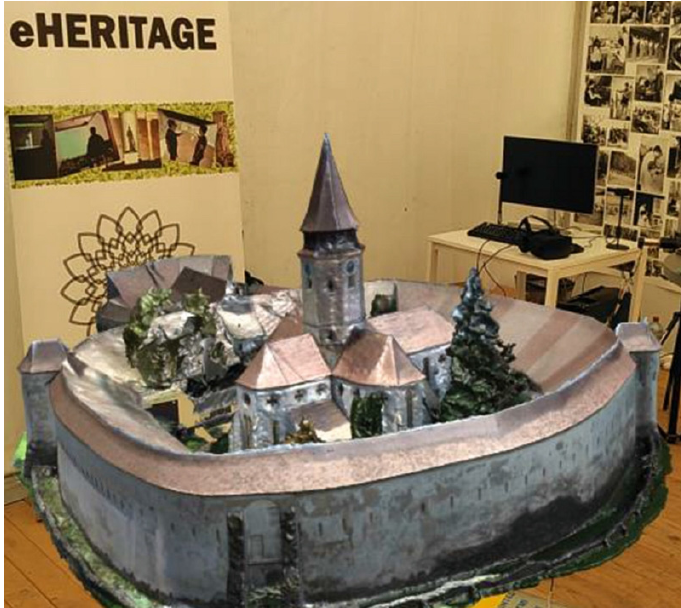
Figure 6. An example of mobile AR application for exploration of the 3D reconstructed Prejmer Fortified Church, a UNESCO monument from Transylvania, Romania, courtesy of Voinea et al. [51].